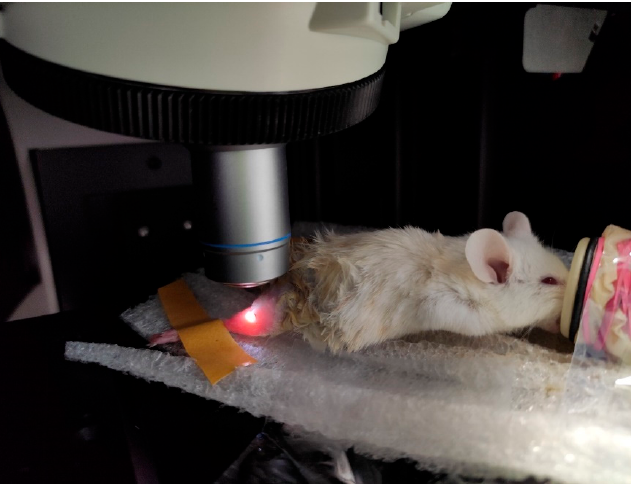
Figure 3. The mouse in the working field of the confocal Raman spectrometer.